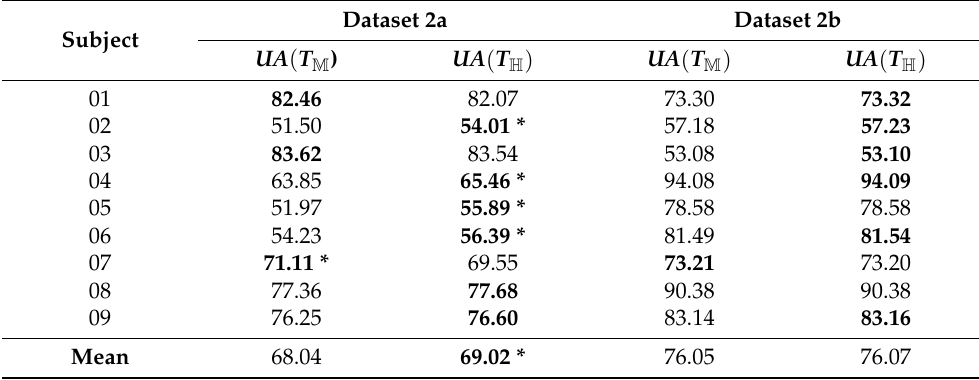
Table 7. Comparison between the proposed adaptive threshold and the method from [39], using non-subject-specific